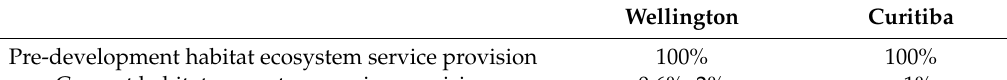
Table 6. Comparison of pre-development, current, and potential future provision of habitat in Wellington and